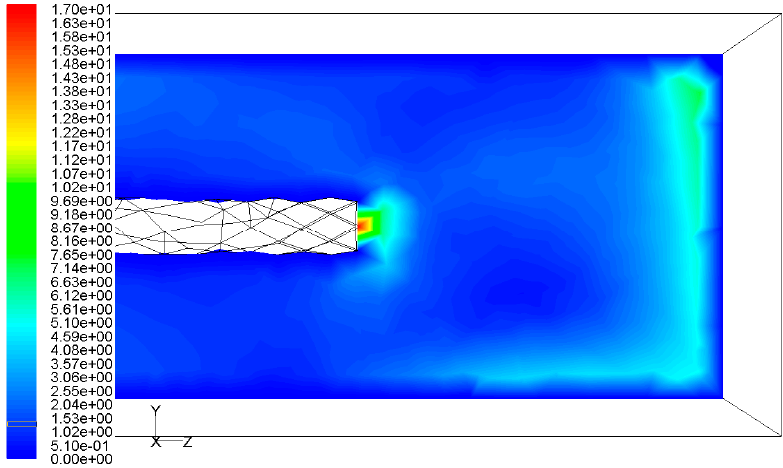
Figure 6. Airflow velocity contour 2 m away from the side wall (m/s).